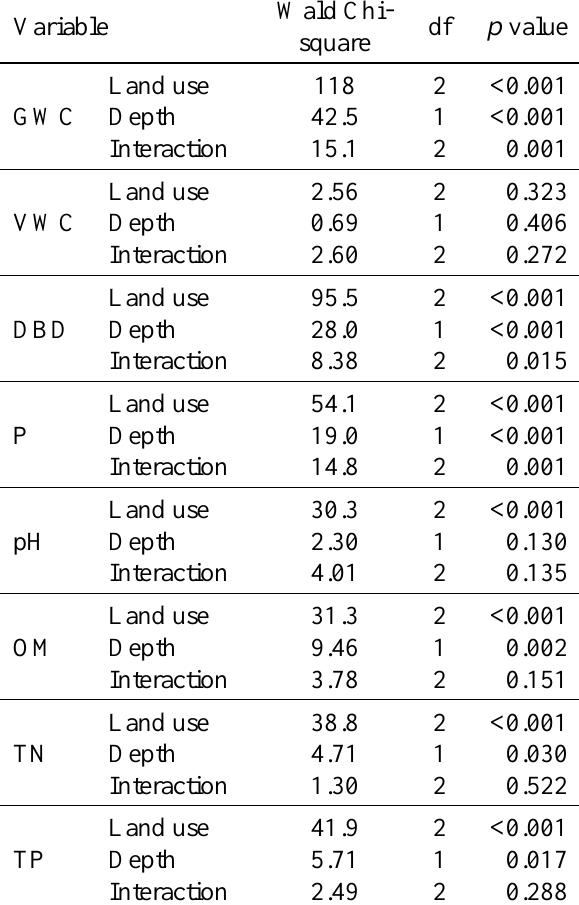
Table 1. The results of Generalised Linear Models